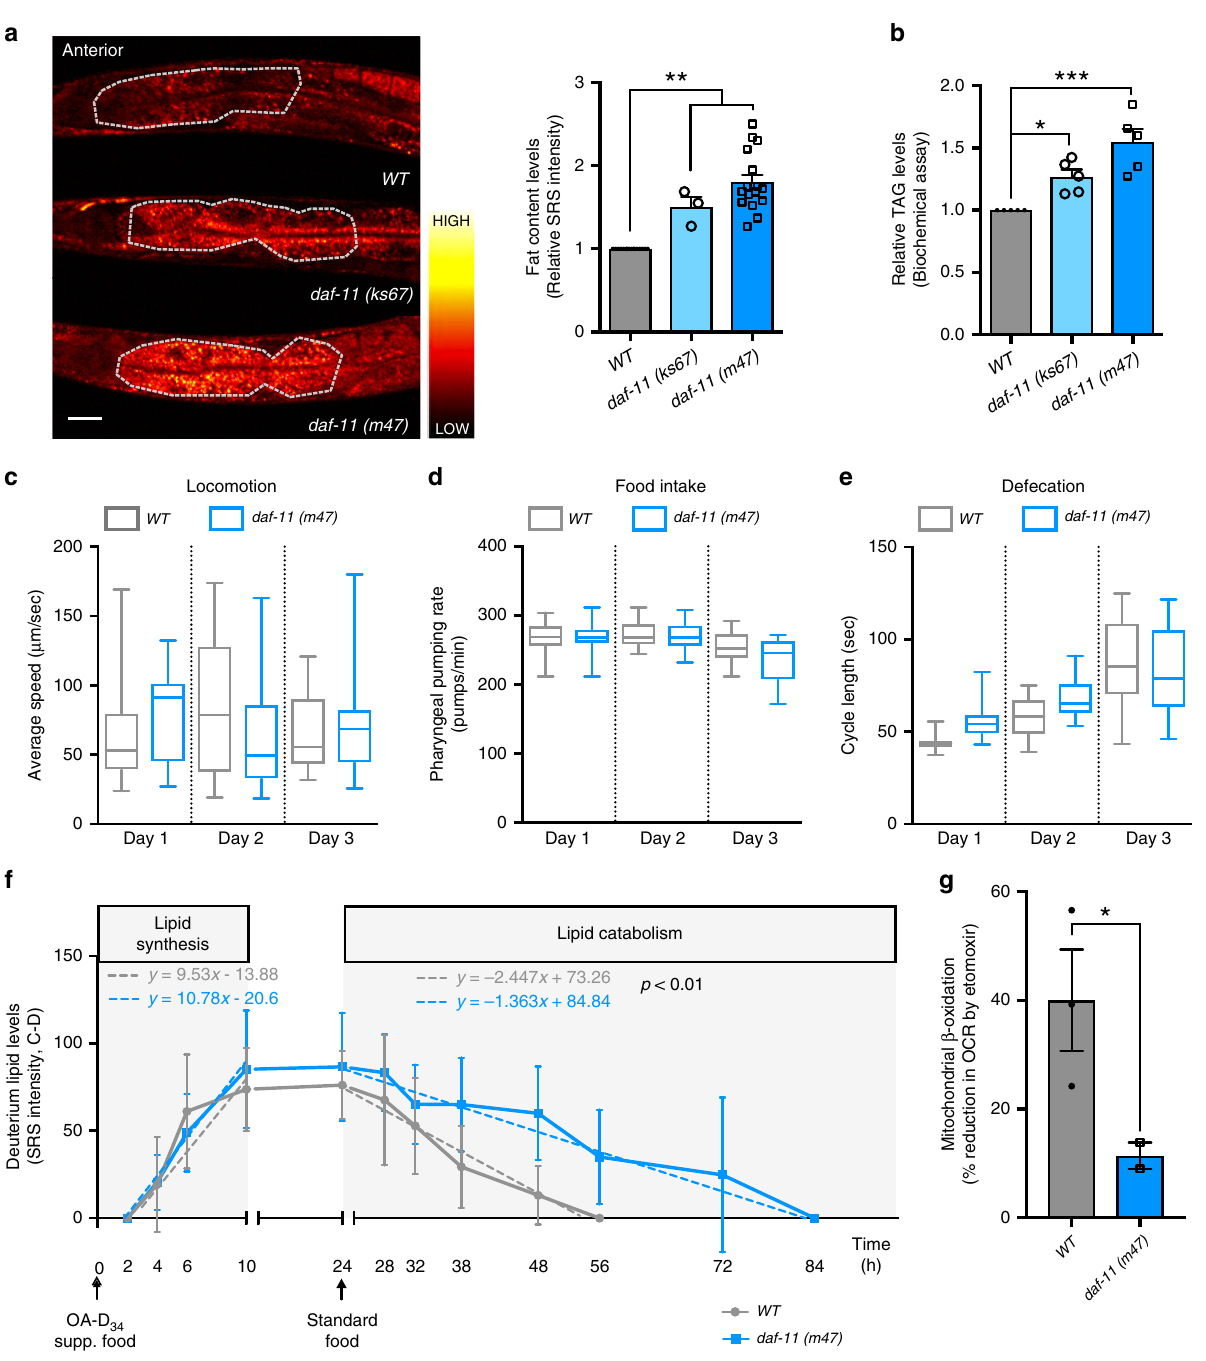
mitochondrial β -oxidation inhibitor, in order to determine the percentage of oxygen consumption due to fatty-acid oxidation. We found that mitochondrial β -oxidation is decreased in the daf-11 mutants compared to wild-type controls (Fig. 1g). We also noted that despite the reduction in lipid catabolism, the total oxygen consumption rate is not decreased in the daf-11 mutants (Supplementary Fig. 2f), which suggests no reduction in total energy expenditure. Together, these results reveal that the guanylyl cyclase DAF-11 directly regulates fat metabolism in peripheral fat storage tissues without changing food intake, and its mutation shifts the balance away from fat oxidation without decreasing energy